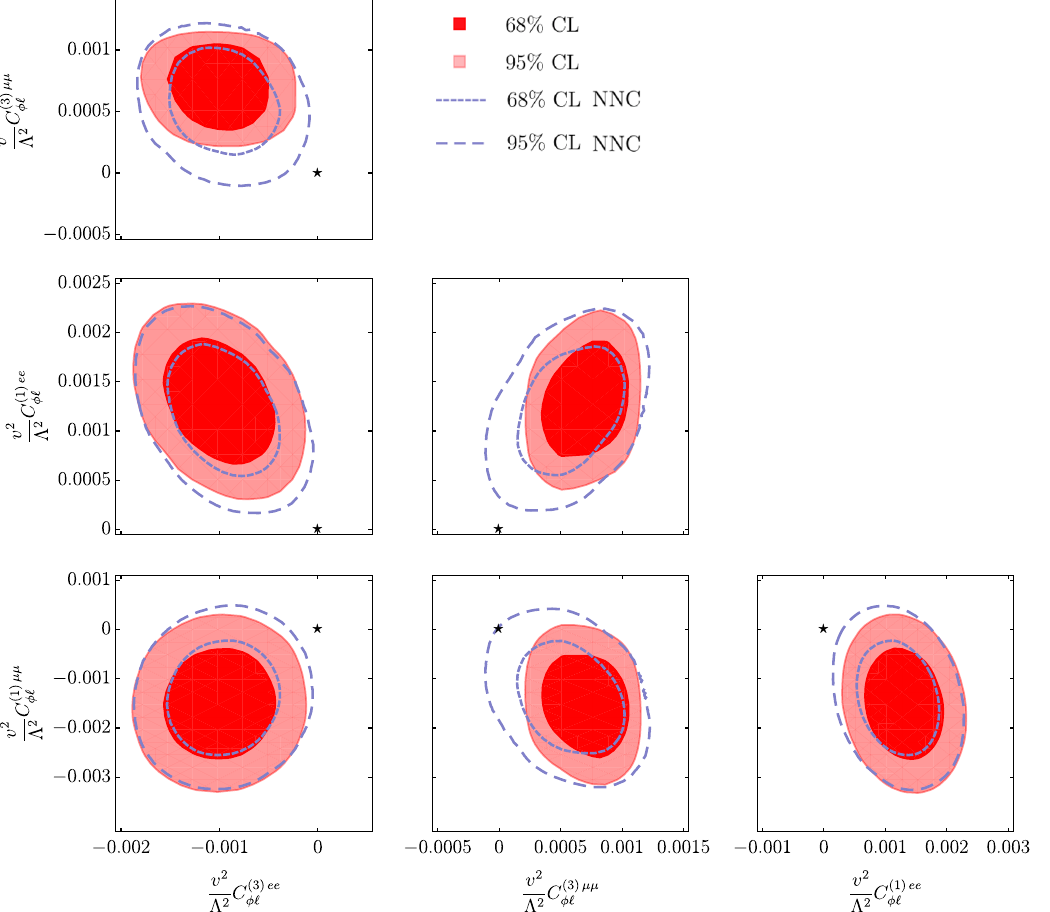
Figure 3 . Global Fit in the 6-dimensional scenario with C (3) ee C (1) ττ